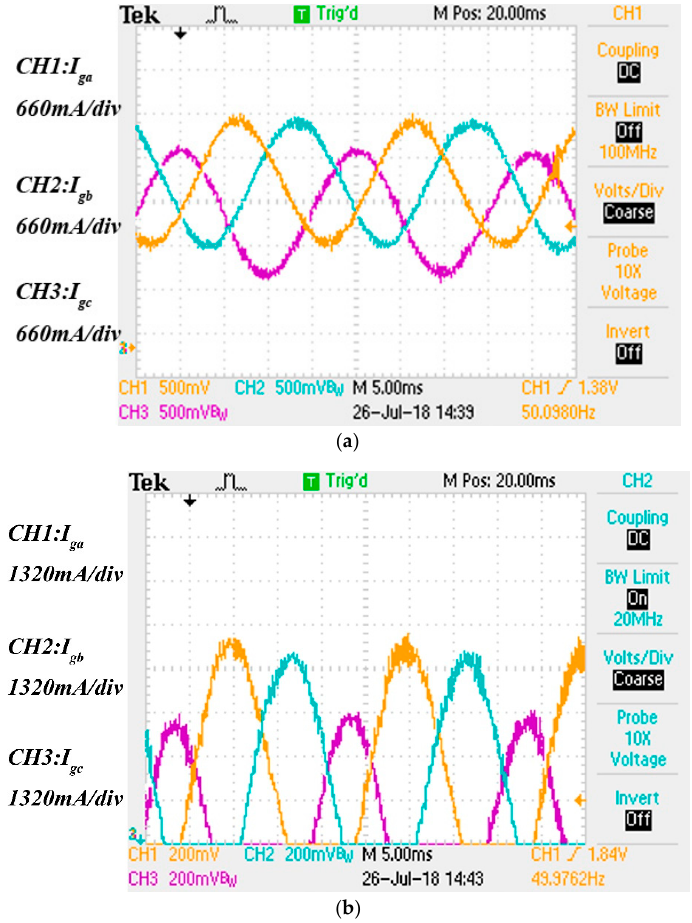
Figure 10. Waveforms of grid current with dc components at different current reference without suppression control. ( a ) 1 dref i = A. ( b ) Zoom-in detail of Figure 10a.